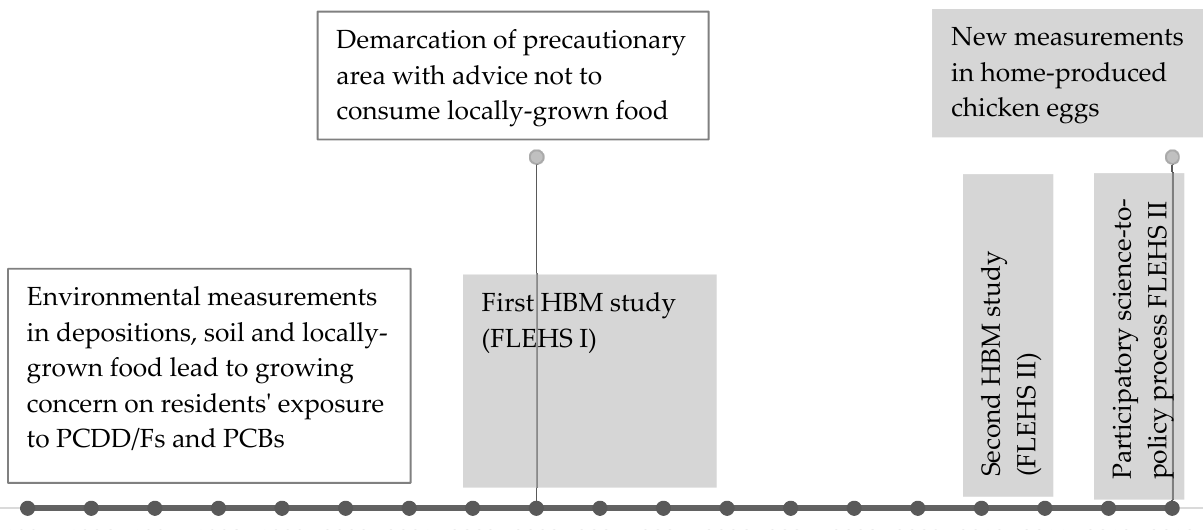
Figure 1. Time-flow of the sequence of research activities on polychlorinated dibenzo-p-dioxins and furans (PCDD/Fs) and polychlorinated biphenyls (PCBs) in the region of Menen. Activities in the grey boxes are addressed in this article. FLEHS = Flemish Environment and Health